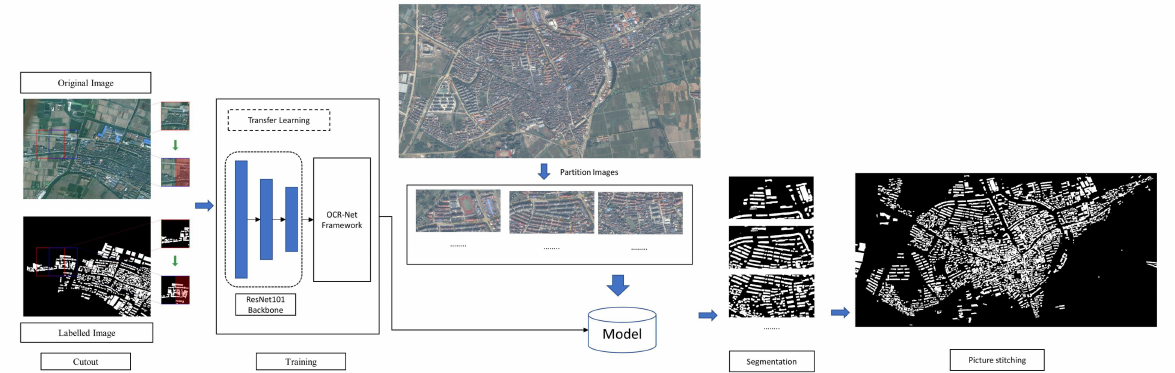
Figure 2 . Pipeline of this research for traditional village semantic segmentation using deep learning.